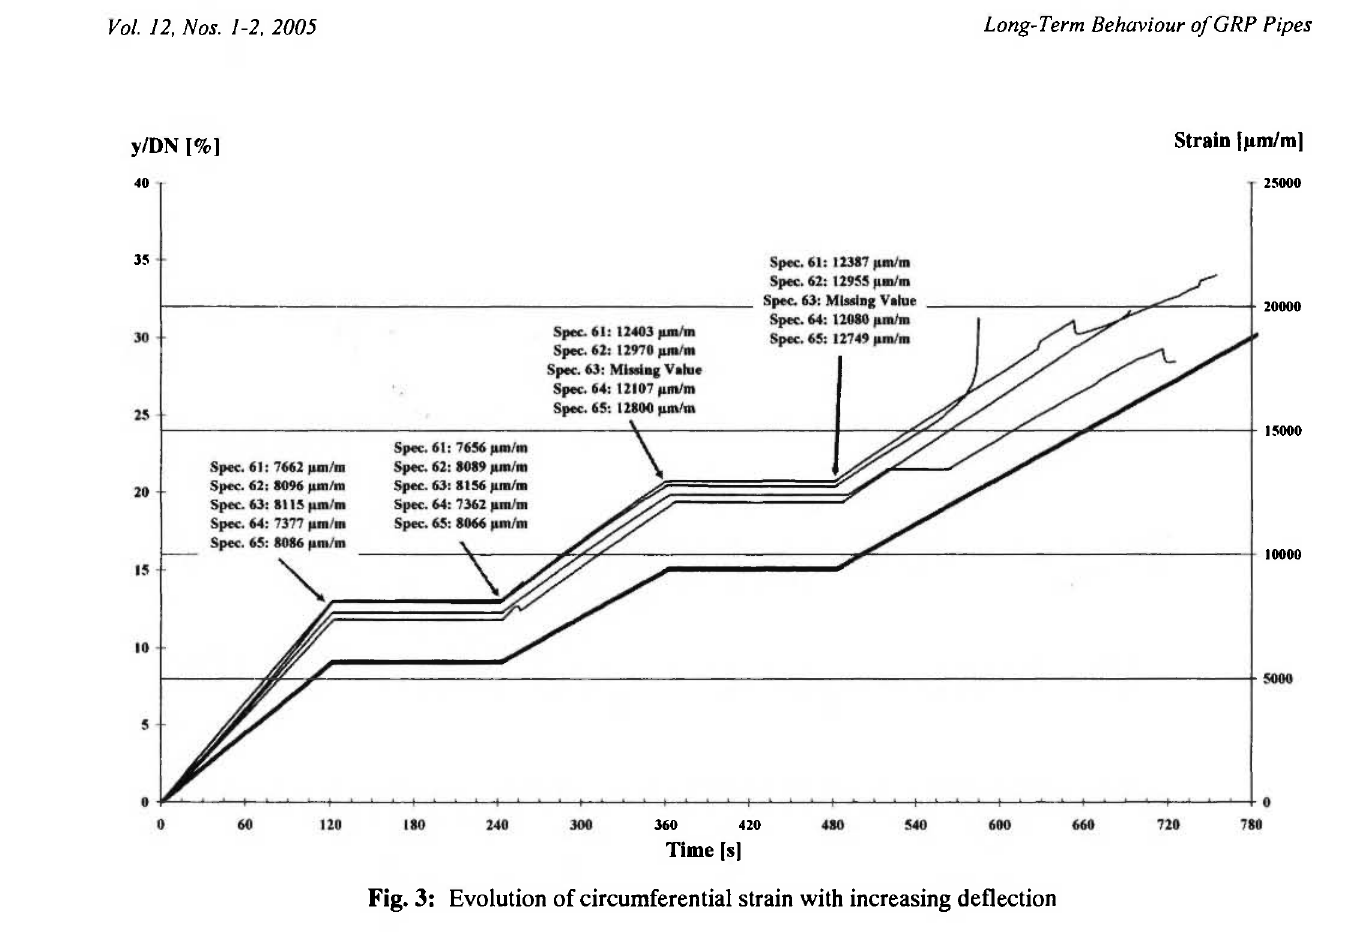
Fig. 3: Evolution of circumferential strain with increasing deflection